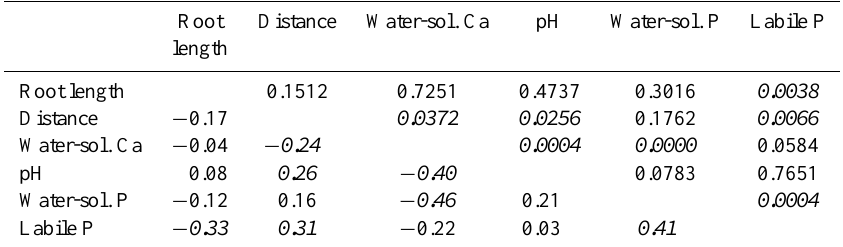
Table 4. Pearson correlation coefficients (lower part of the table) and p-values (upper part of the table) for root length density, distance from the stem, water-soluble Ca, pH and water-soluble P on the Chicken Creek Catchment (CCC). The numbers in italic indicate significant correlations between the respective variables ( p > 0 .